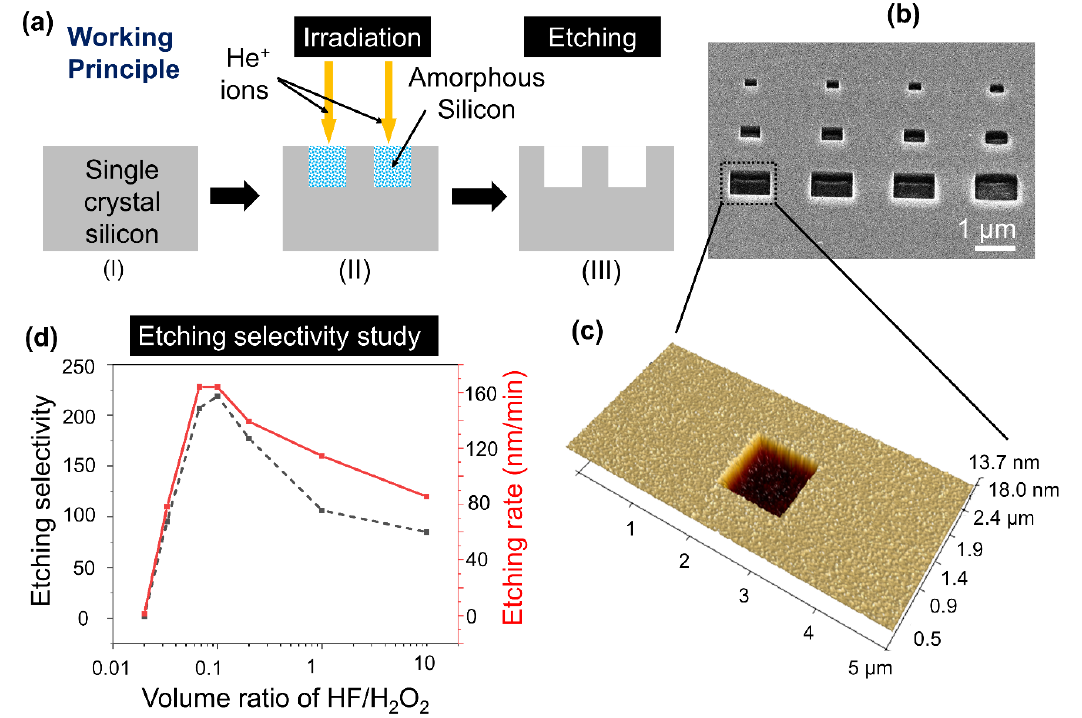
Figure 1. ( a ) Principle of helium ion ‐ bombardment enhanced etching for fabricating structures at the micrometer scale: (I) start with single ‐ crystal Si, (II) irradiate with focused helium ions, (III) etch away amorphous Si formed by helium ion irradiation. ( b ) an SEM image of an array of Si square holes of different sizes fabricated by HIBEE. ( c ) AFM topography measurement of an etched square hole. ( d ) Etching selectivity of irradiated Si over non ‐ irradiated Si, as well as the etching rates of irradiated Si for different HF/H 2 O 2 mixing ratios.